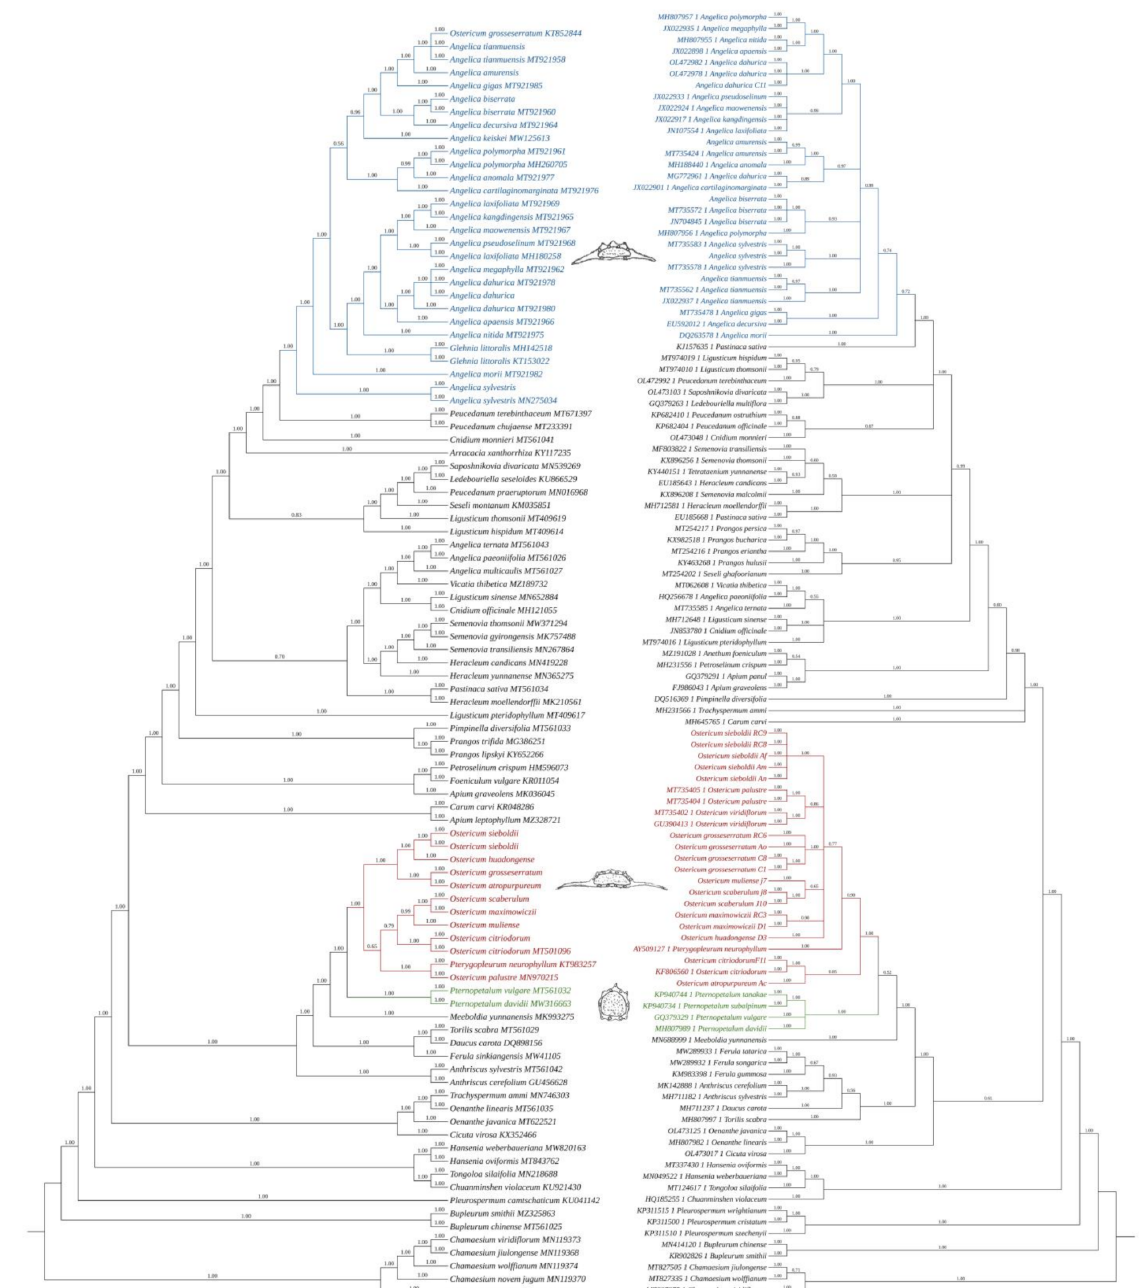
Figure 7. Phylogenetic relationships between Angelica and Ostericum and related groups are inferred from Bayesian inference (BI) based on the protein-coding genes of plastid genomes ( left ) and nrITS ( right ). Bayesian posterior probabilities (BI PPs) are presented at the nodes. The complete plastid genome sequences and ITS sequences obtained from NCBI show the GenBank number adjacent to the species names. Angelica is highlighted in blue, Ostericum is highlighted in red, and Pternopetalum is highlighted in green. The illustration of the fruit in the transverse section from top to bottom is A. dahurica , O. scaberulum , and P. davidii